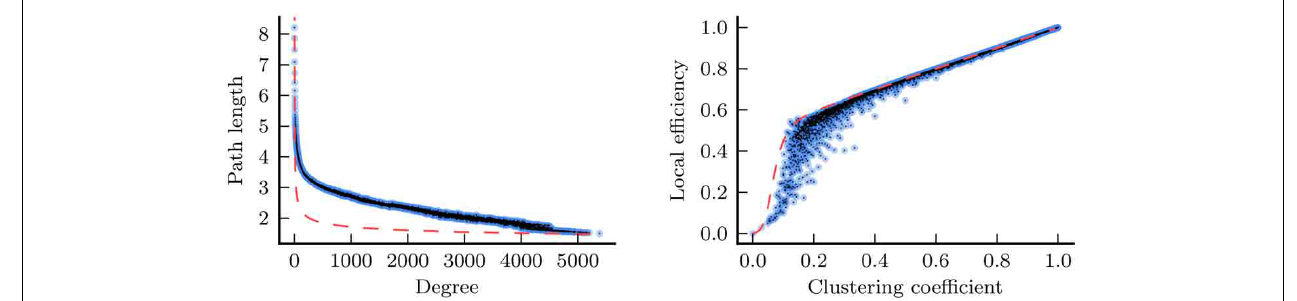
FIGURE 7 | Relationships between degree and path length (left), and between clustering coefficient and local efficiency (right) for the nodes from every functional network in the study (joint histograms with 5000 bins, based upon data from a total of 275 networks/ 3489756 nodes; 5 networks in the study contained more than one component, thus were excluded from these plots). Data are shown before Z -normalization was applied. For the purposes of comparison, the dashed red lines show the same relationships for Erd˝os-Rényi (ER)